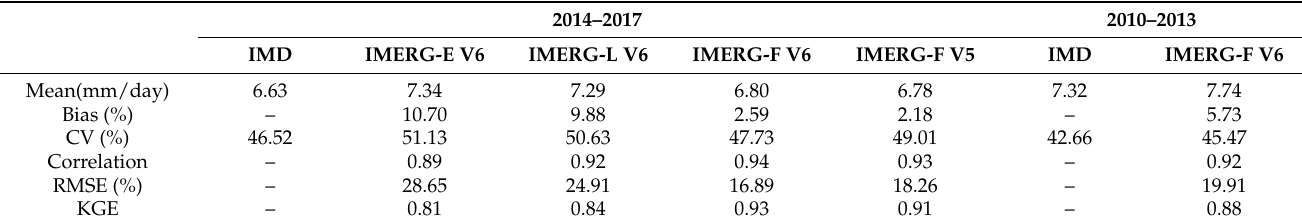
Table 3. Error statistics in the IMERG precipitation products as compared to the IMD rain-gauge-based dataset for all-India daily monsoon rainfall